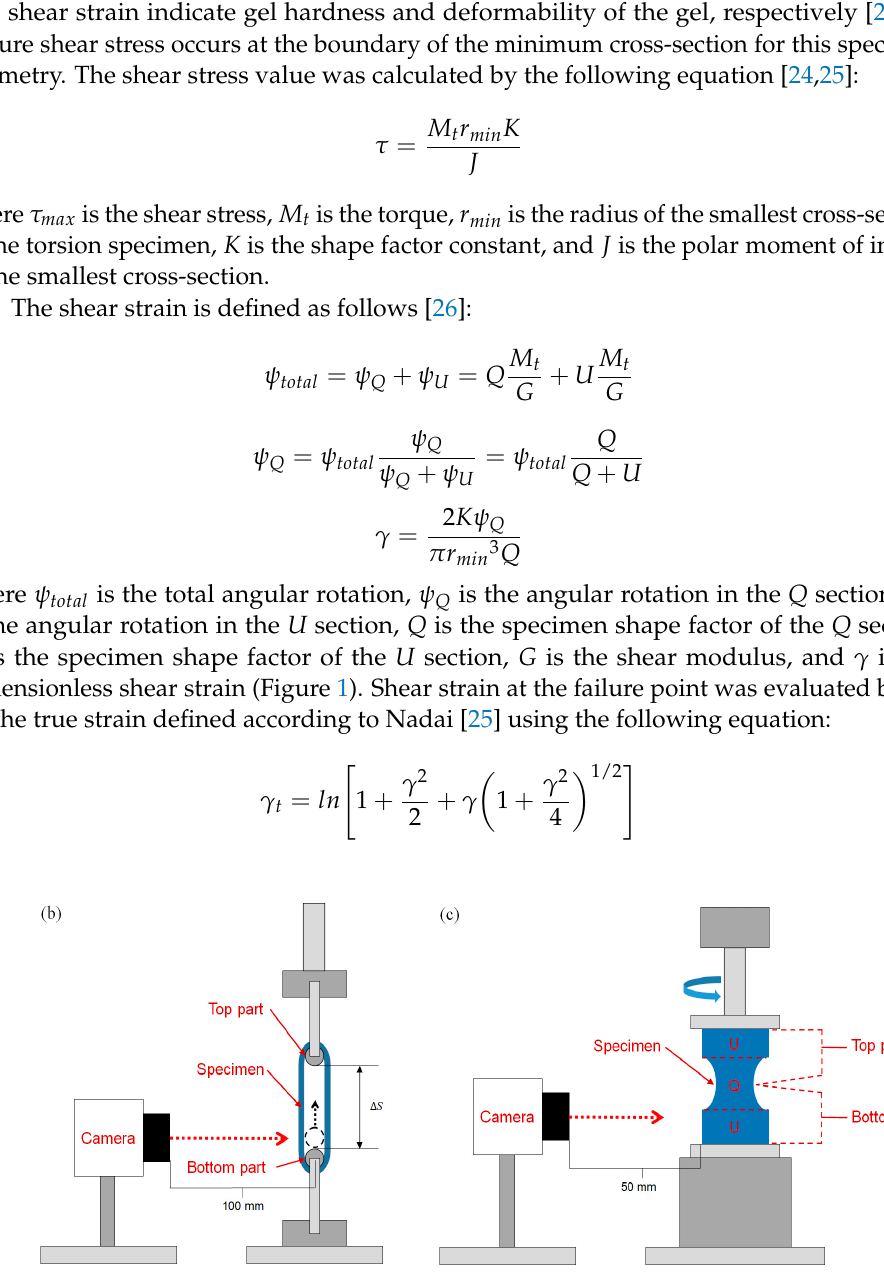
Figure 1. The image acquisition systems for the ( a ) penetration test, ( b ) ring tensile test, and ( c ) torsion test.